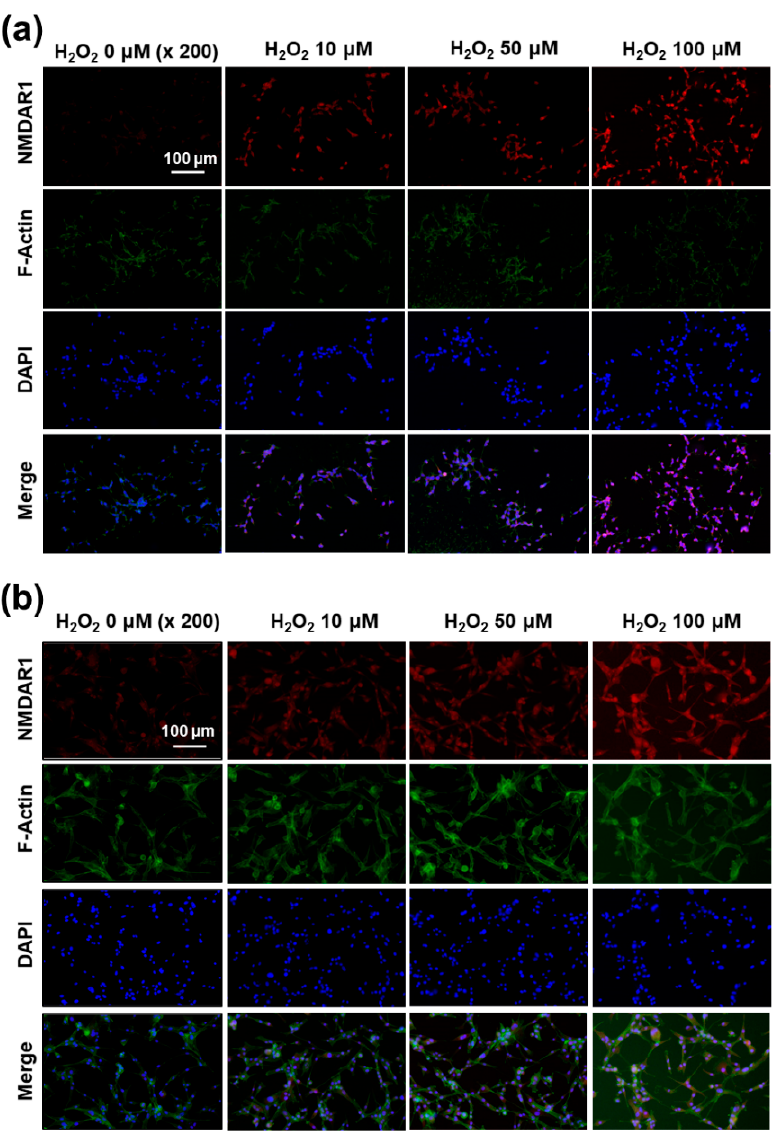
Figure 9. The effect of oxidative stress on the expression of NMDAR1 at SH-SY5Y cells ( a ) and U87MG cells ( b ). SH-SY5Y cells (1 × 10 5 ) or U87MG cells (1 × 10 5 ) were treated with H 2 O 2 for 6 h. After that, cells were fixed with 4% paraformaldehyde and stained with anti-NMDAR1 antibody. The cells were incubated with a Cy3 (red fluorescence) goat anti-rabbit antibody diluted 1:500 in blocking buffer for 2 h, and a Phalloidin was added for incubation (F-actin, Alexa Fluor 488, green fluorescence) for 30 min. The use of red, green and blue color represents the staining of the NMDAR1 protein, actin and nucleus in cells.